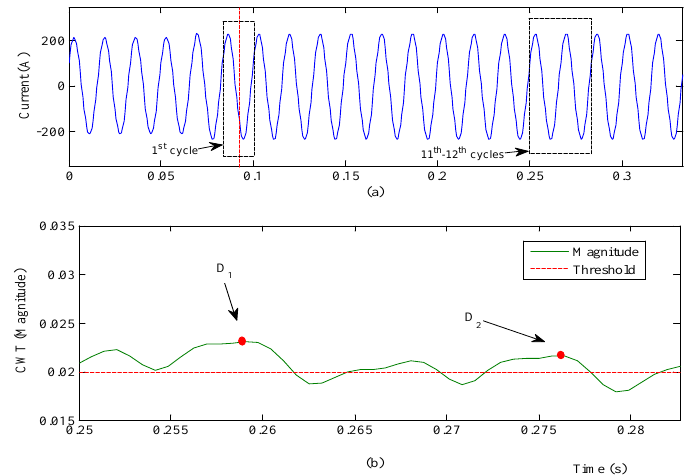
Figure 7. HIF event in (13-Bus) is detected and classified, ( a ) I n ; ( b ) D 1 and D 2 of the normalized I n in the 11th–12th cycles.